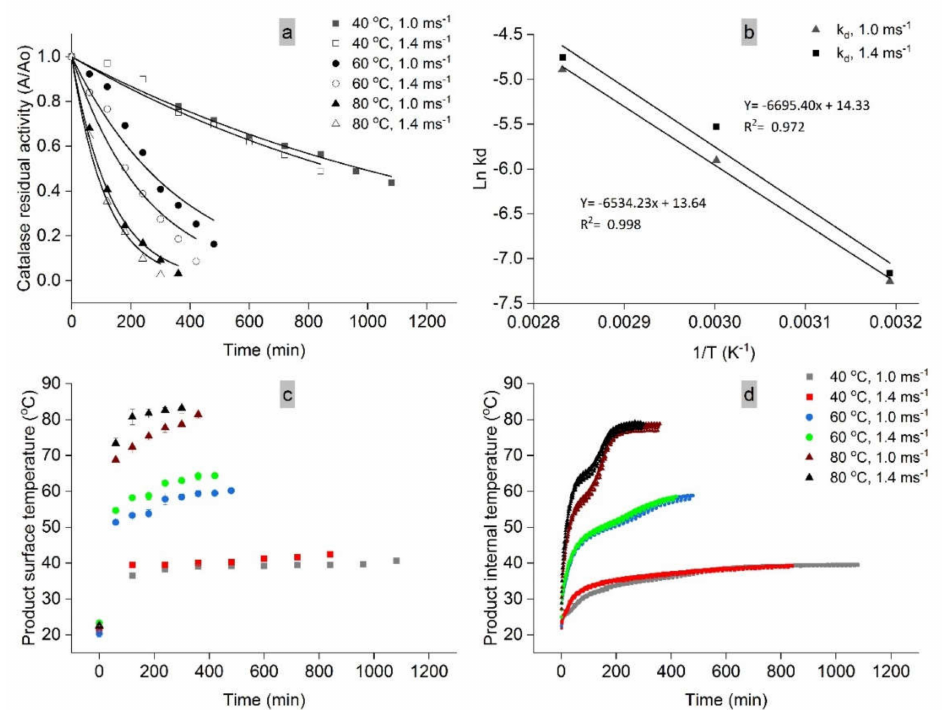
Figure 4. ( a ) Kinetics of catalase activity; ( b ) Arrhenius plot for the energy of deactivation of catalase; ( c ) product surface temperature; ( d ) product internal temperature during drying of mango variety Sindri at 40 ◦ C, 60 ◦ C, and 80 ◦ C; air velocity 1.0 ms − 1 or 1.4 ms − 1